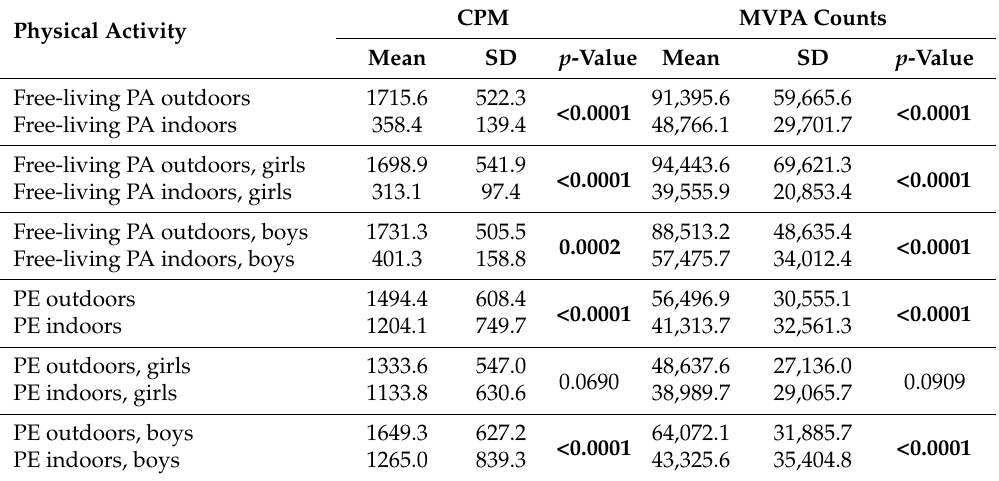
Figure 2. PA intensity levels (CPM) per grade, indoors and outdoors during free-living PA and PE, Sweden 2012–2013; * Free living PA indoors differs between grades ( p < 0.001). Sweden 2012–2013; Free living PA indoors differs between grades ( p < 0.001). Table 3. Differences in accelerometer counts-per-minute (CPM) and moderate-to-vigorous PA (MVPA) counts indoors vs. outdoors during free-living PA and